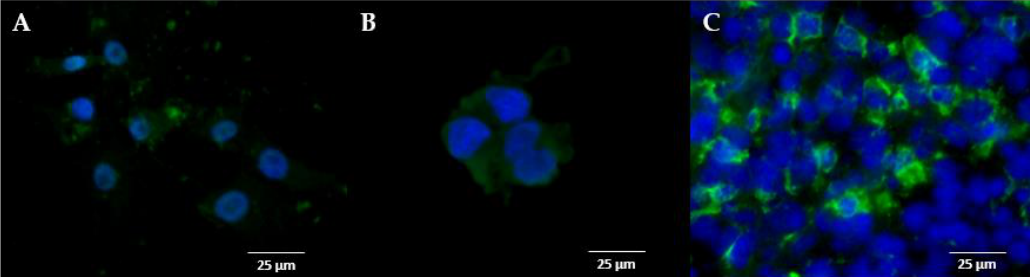
Figure 1. Immunofluorescent staining of sigma-1 receptors (sig1R). Representative image of the sig1R staining ( A ) in U87-MG cells grew in vitro, ( B ) in HEK-293 cells overexpressing human sigma-1 receptor (hsig1R) grew in vitro and ( C ) in a cryosection of U87-MG tumour cells orthotopically implanted in a mouse brain (scale bar: 25 µ m, x40, green channel: sig1R staining, blue channel: nucleus